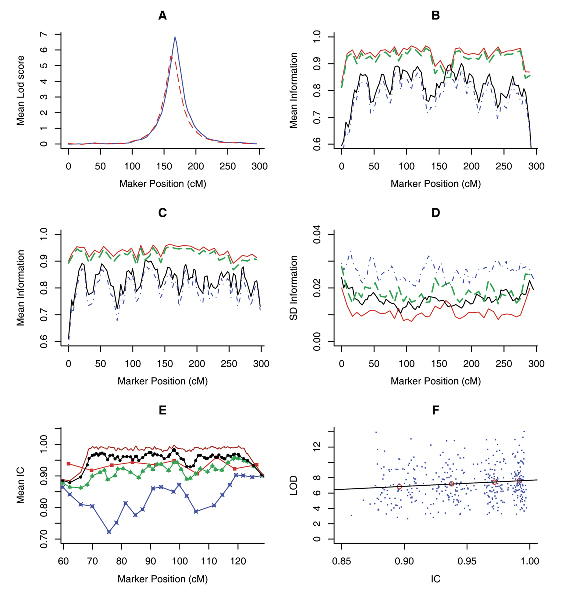
LOD scores, IC and RI for microsatellites and SNPs. A, Mean LOD score for microsatellites (dashed red) and SNPs with 3-cM spacing (solid blue) for chromosome 1. B, Mean IC and RI for microsatellites (IC: upper solid red, RI: long dashed green) and SNPs with 3-cM spacing (IC: lower solid black, RI: dot dashed blue) for chromosome 1. C, Mean IC and RI for microsatellites (IC: upper solid red, RI: long dashed green) and SNPs with 3-cM spacing (IC: lower solid black, RI: dot dashed blue) for chromosome 7. D, Standard deviation of IC and RI for microsatellites (IC: lower solid red, RI: long dashed green) and SNPs with 3-cM spacing (IC: upper solid black, RI: dot dashed blue) for chromosome 1. E, Mean IC for microsatellites (solid Red with squares) and SNPs (0.3 cM: solid Brown, 1 cM: black with dots, 2 cM: green with triangles, 3 cM: blue with stars) for chromosome 7. F, LOD against IC at the disease locus in chromosome 1. Regression line of the scatter plot and average IC at 4 map densities are also shown here. All these figures use marker data for Danacaa group only.